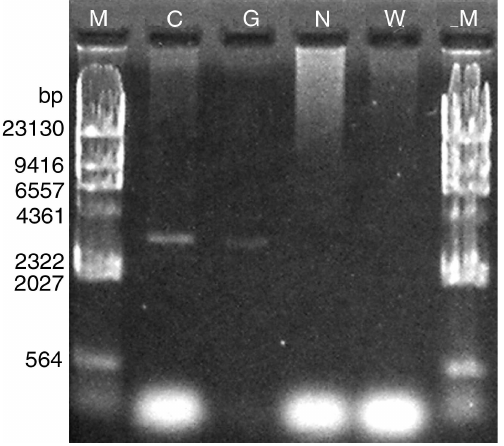
Figure 4. Agarose gel electrophoresis of RT-PCR products from mRNA of Methanosarcina mazei LYC with the dag gene specific primer set. C, PCR products from cDNA after RT reaction with mRNA extractedfromsinglecellsof M. mazei LYC; G, PCR products from genomic DNA of M. mazei LYC; N, PCR products without RT reaction from DNA-free RNA solution extracted from single cells of M. mazei LYC (negative control); W, PCR products from MilliQ-Wa- ter; and M, molecular mass standard ( λ Hin